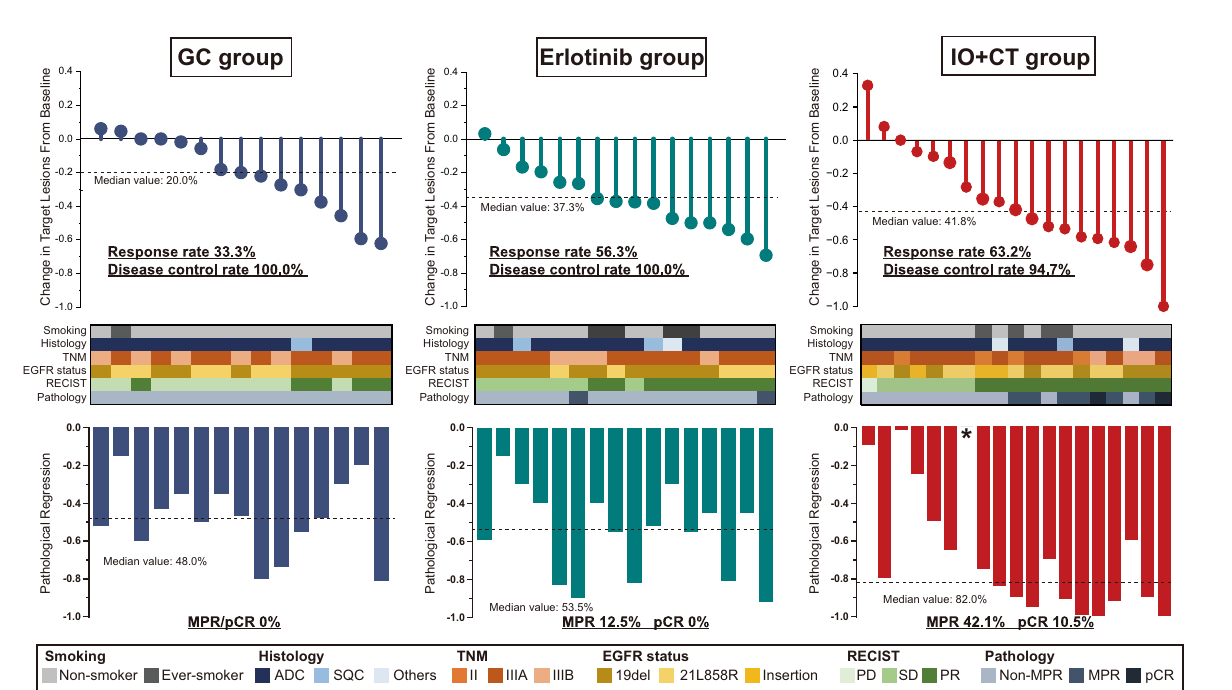
Fig. 2 Ef fi cacy of neoadjuvant treatments for EGFR-mutant NSCLC. Comparison of different treatment modalities for resectable EGFR- mutant NSCLC in regard to radiological response and pathological assessment by integrating chemotherapy and EGFR-TKI cohorts from CTONG1103 study. ADC Adenocarcinoma, SQC Squamous cell carcinoma, SD Stable disease, PR Partial response, PD Progression disease, CR Compelete response, MPR Major pathological response, pCR P athological complete